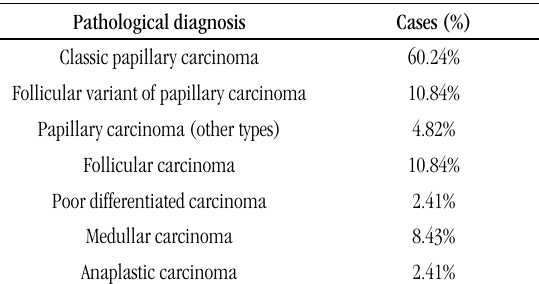
tABLE 3 – Malignant findings from the